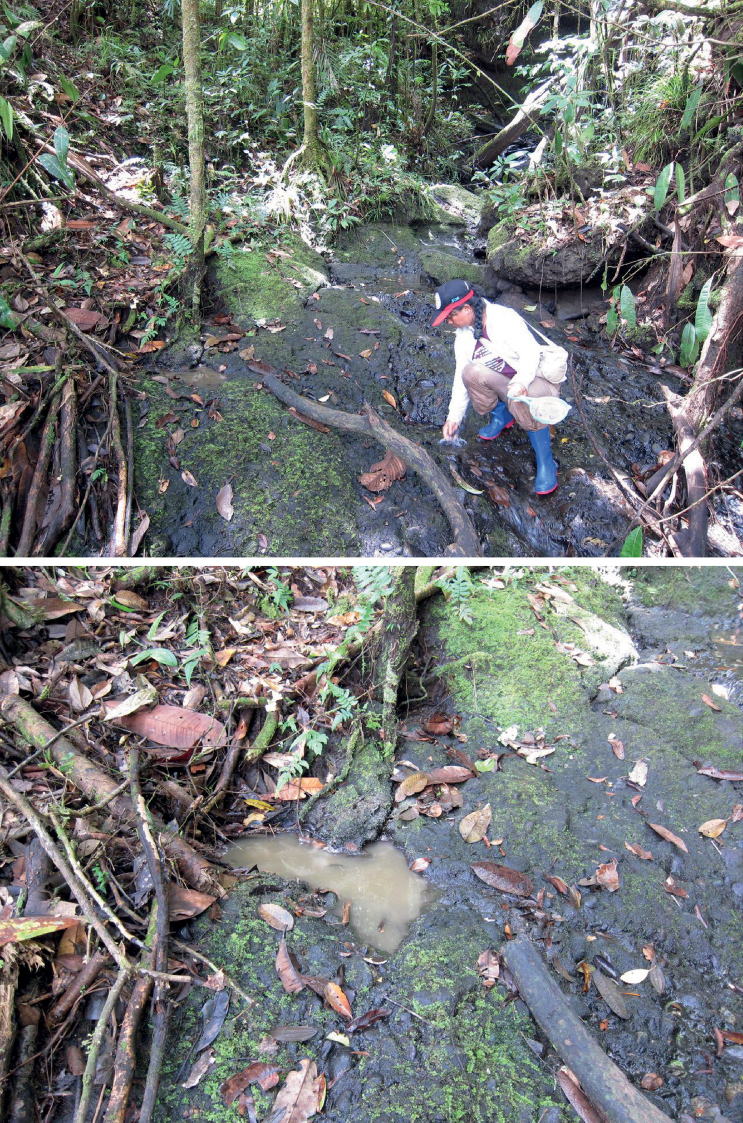
Habitat of Exocelina unipo sp. n.: Indonesia, Papua Province, Nabire-Enarotali Road, 108th km, stream on the steep slope (Suriani Surbakti).